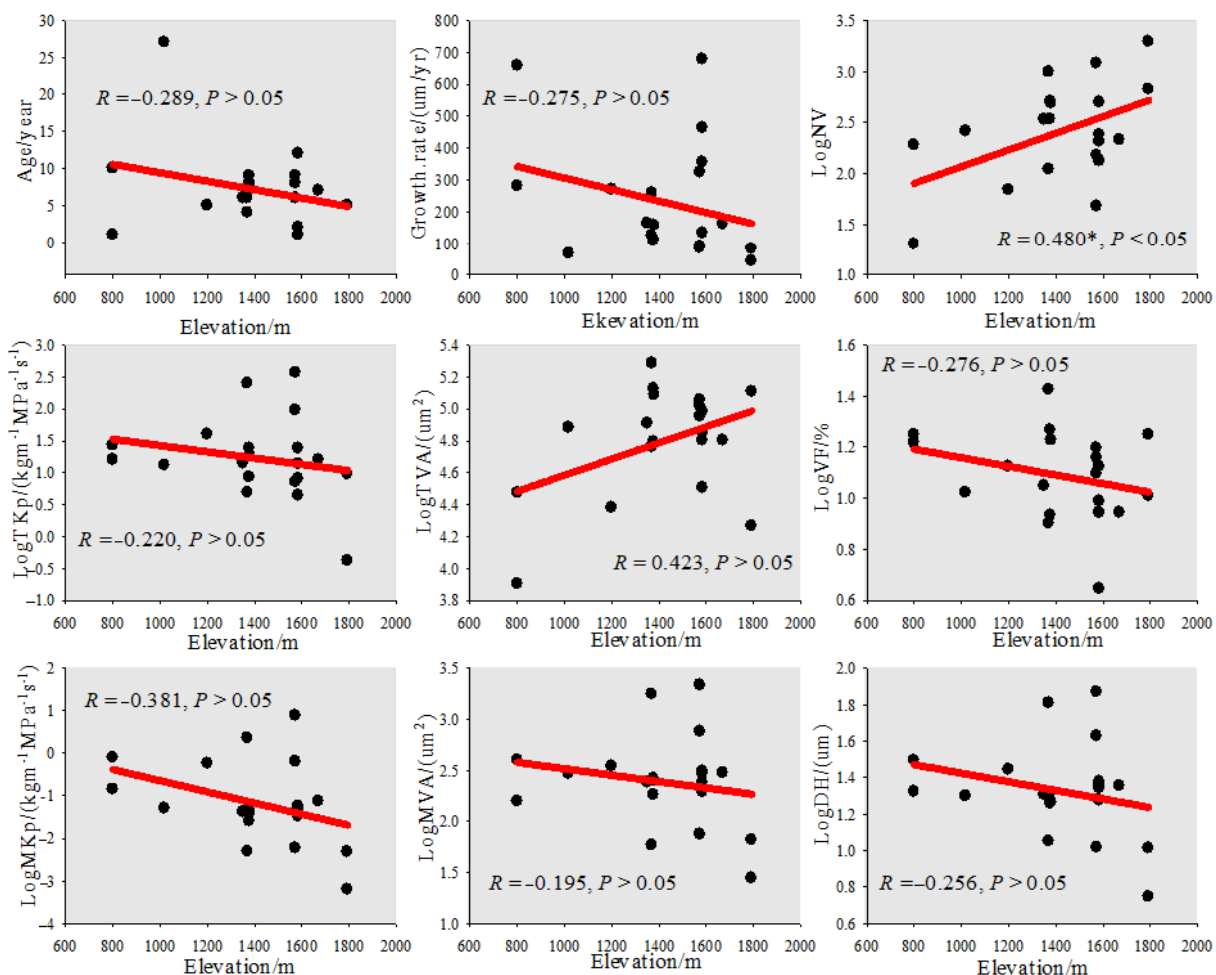
Figure 8. The anatomical characteristics of the root vessels of Zygophyllaceae plants in China’s arid and semi-arid regions and change in the law of altitude gradients. Age: (year); Growth.rate: (μm/year); NV: vessel number; VF: vessel fraction (%); TAV: total vessel area (μm 2 ); MVA: mean vessel area (μm 2 ); TKp: total water transfer efficiency (kg m −1 MPa −1 s −1 ); MKp: mean water transfer